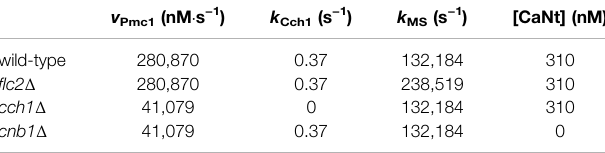
TABLE 3 | List of parameters that change depending on the modeled mutant strain. All other parameters were kept as in the wild-type model ( Table 2